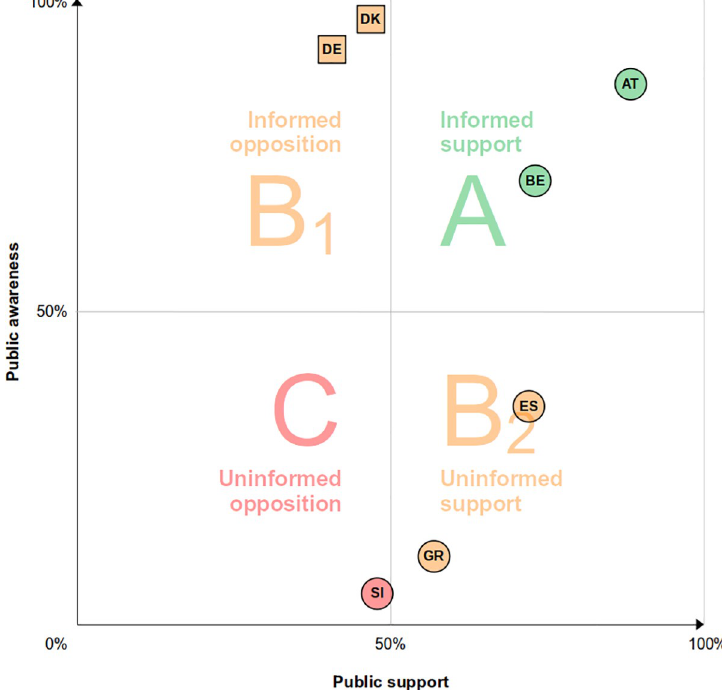
Fig 3. National prevalence of policy awareness against support. Squares represent opt-in countries, and circles represent opt-out countries.